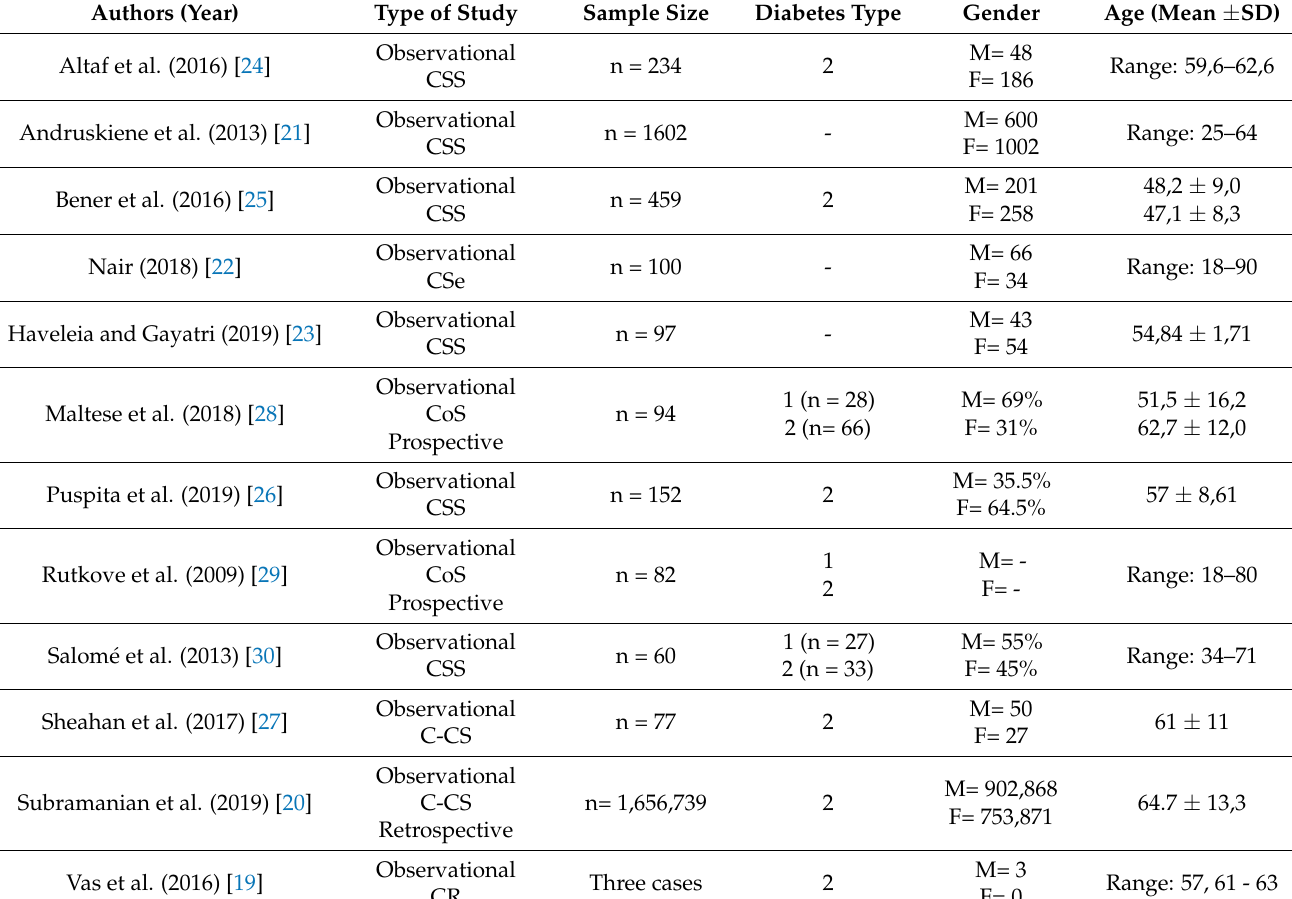
Table 1. Structural characteristics of the included